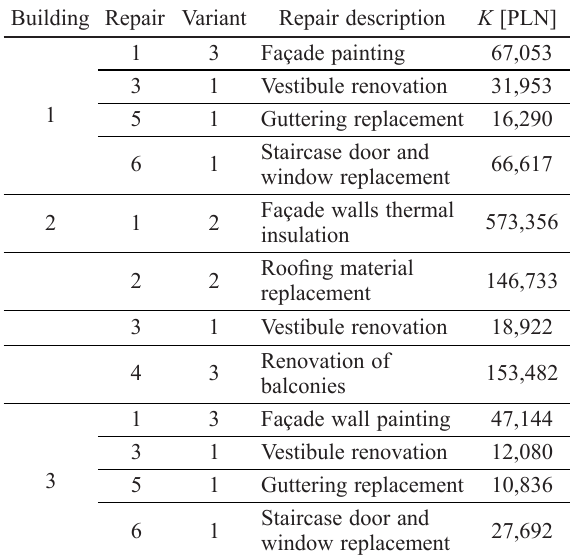
table 8. Details of the repair variants generated (solution 1)